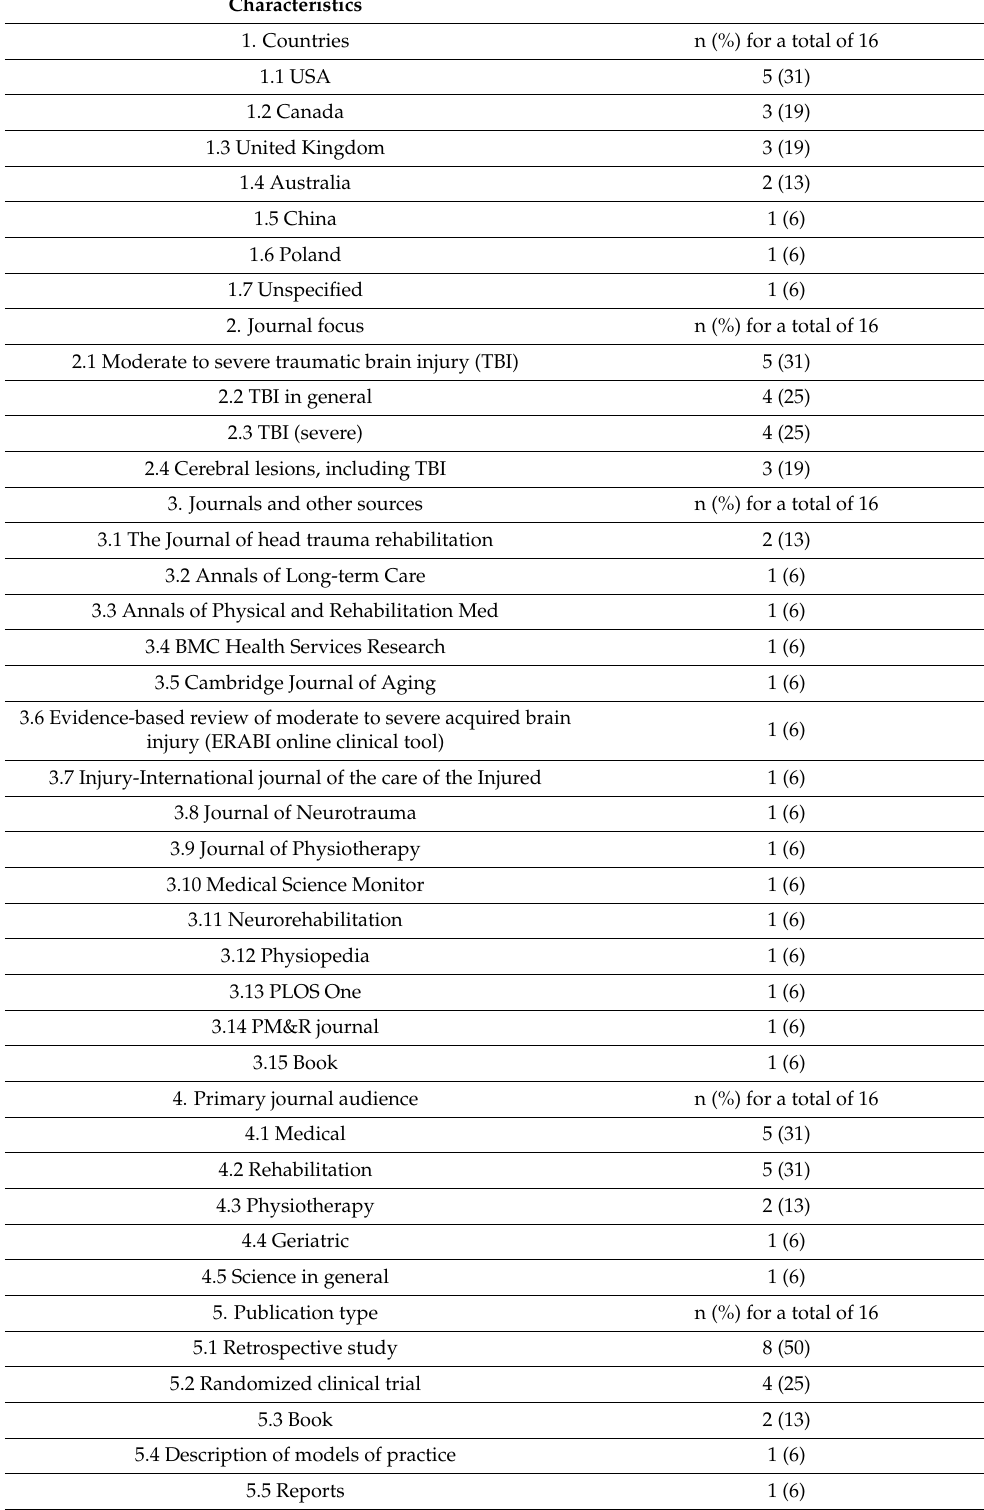
Table 1. Summary of the sources and characteristics of the articles included in this scoping